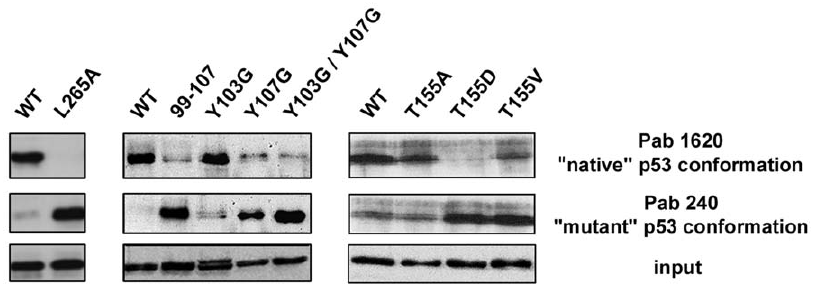
Figure 6. Conformation of p53 mutants. H1299 cells were transfected by vectors for transient expression of p53 proteins. Cell lysates were incubated with mouse monoclonal anti-p53 antibody, either the Pab 1620 recognising only the ‘‘wild-type’’ conformation epitope or the Pab 240 recognising only the ‘‘mutant’’ conformation epitope. Immune complexes and whole lysates (input) were separated by 12% SDS-PAGE and subjected to Western blotting using antibodies against p53 (polyclonal rabbit).